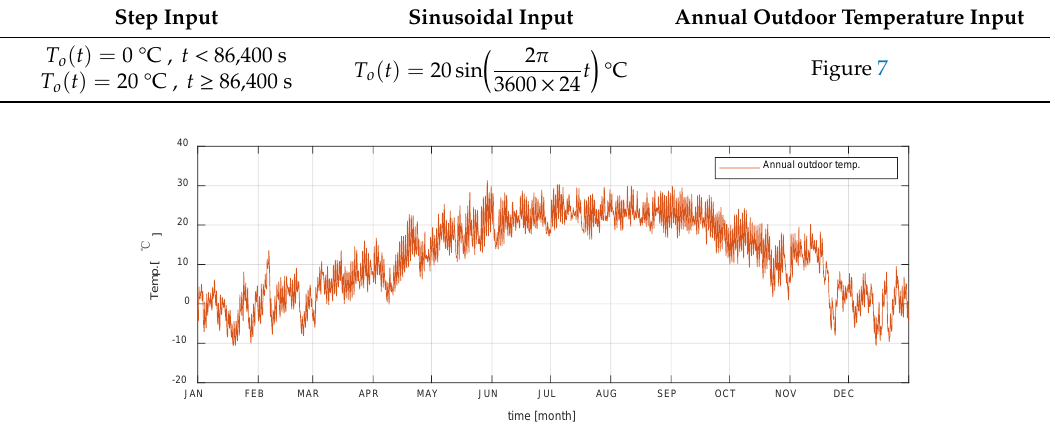
Table 7. Amplitude and time shift comparison with the FDM sinusoidal response.